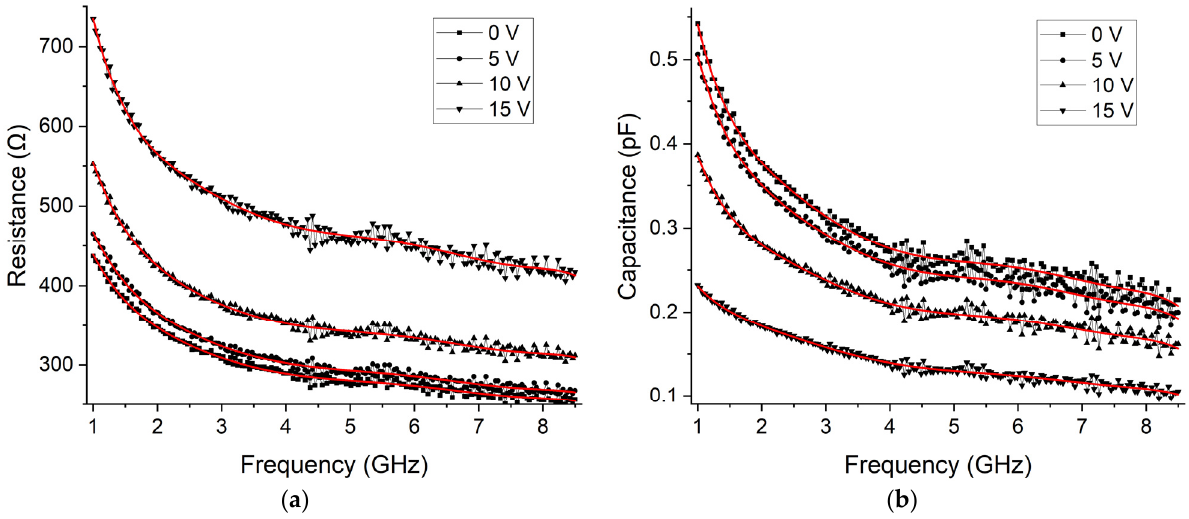
Figure 11. Extracted resistance ( a ) and quantum capacitance ( b ) of graphene for backgate bias voltages of 0 V, 5 V, 10 V, and 15 V. Fitted lines are shown in red for an easier interpretation of the results.